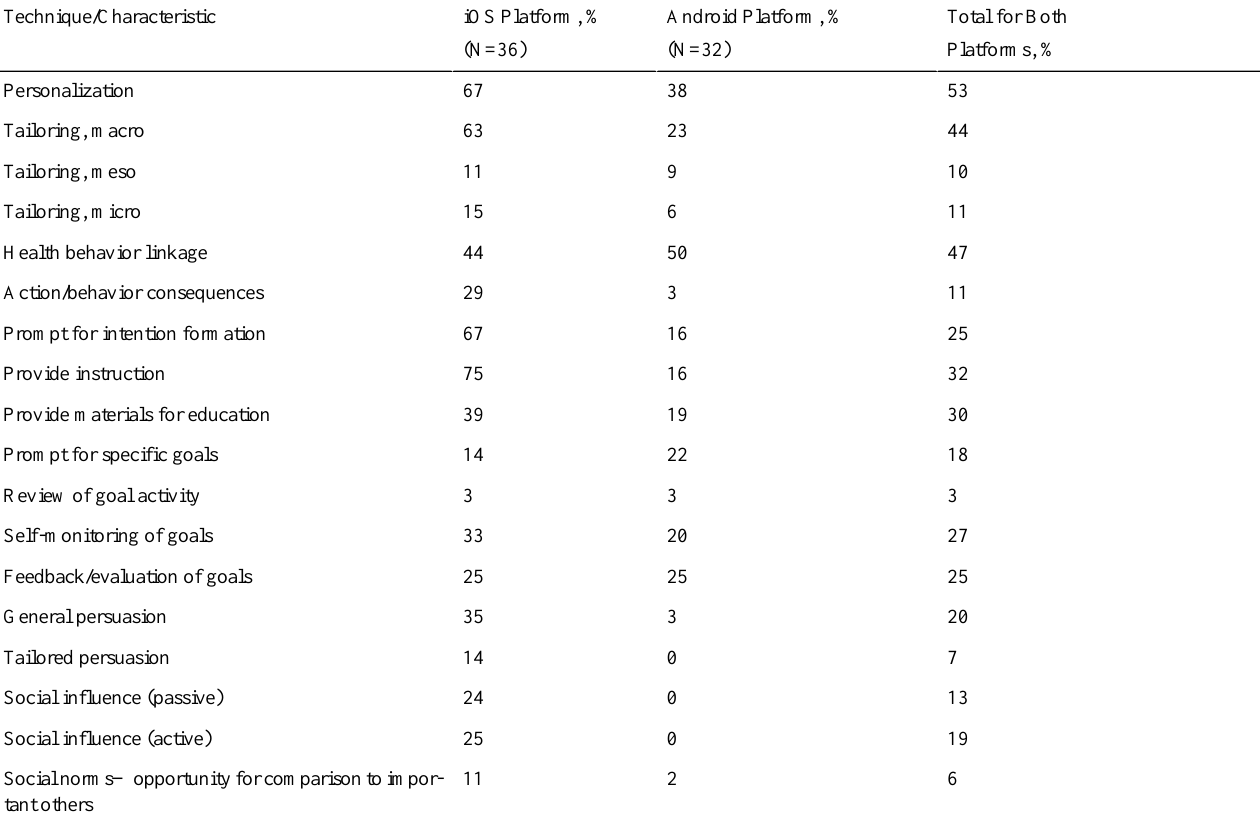
Table 3. Category and platform percentages for health behavior characteristics. Each item was scored as 1=present or 0=not present.